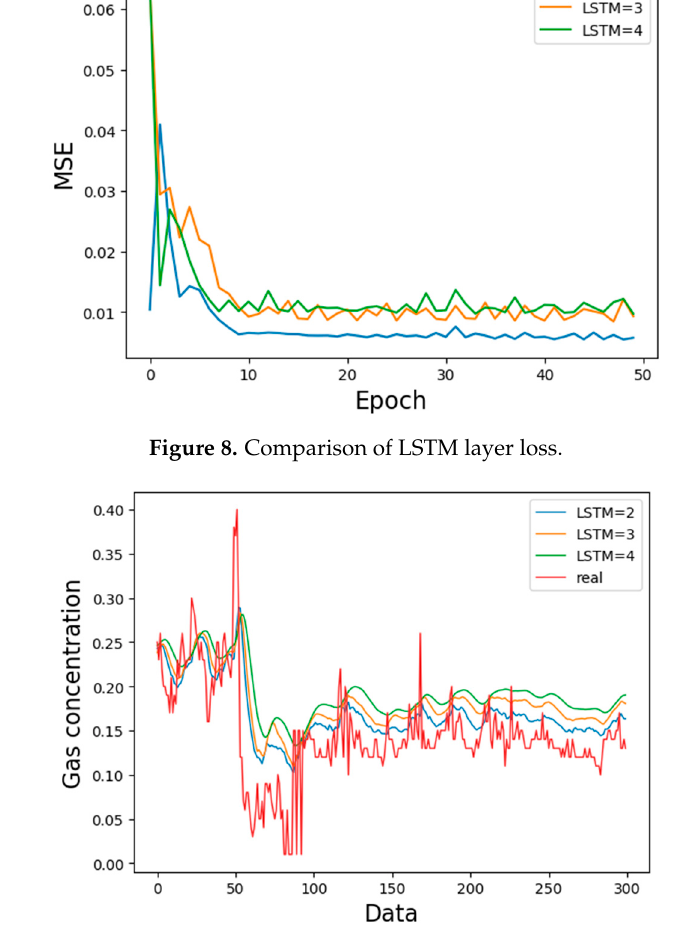
Figure 9. Comparison of LSTM layer number fitting effect. Table 2. LSTM layer prediction results.